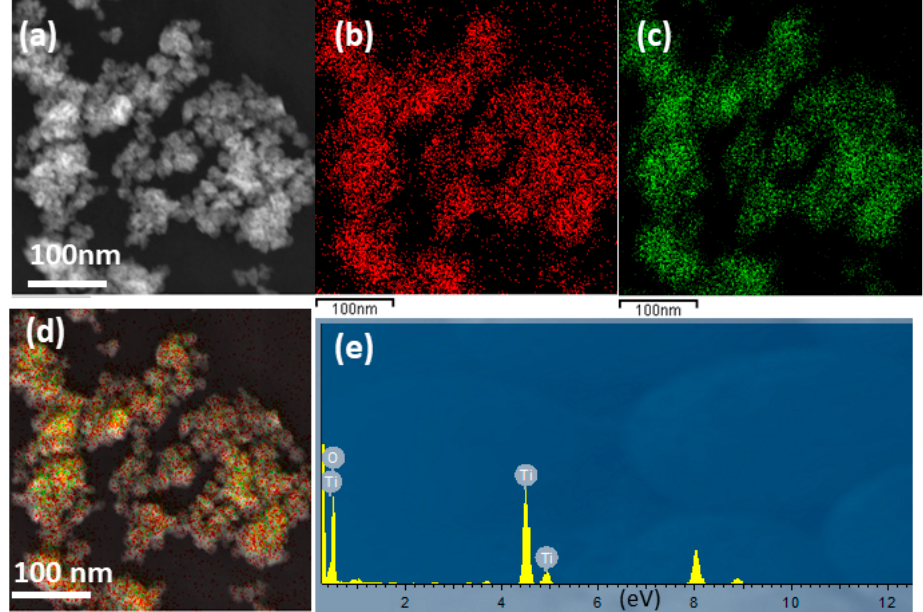
Figure 2. ( a ) TEM scanning image, ( b ) distribution of O, ( c ) distribution of Ti, ( d ) elemental scanning of Ti and O, and ( e ) EDX spectrum of 5 nm TiO 2 nanoparticles with 69.88 and 30.12 as the percentages of O and Ti, respectively.